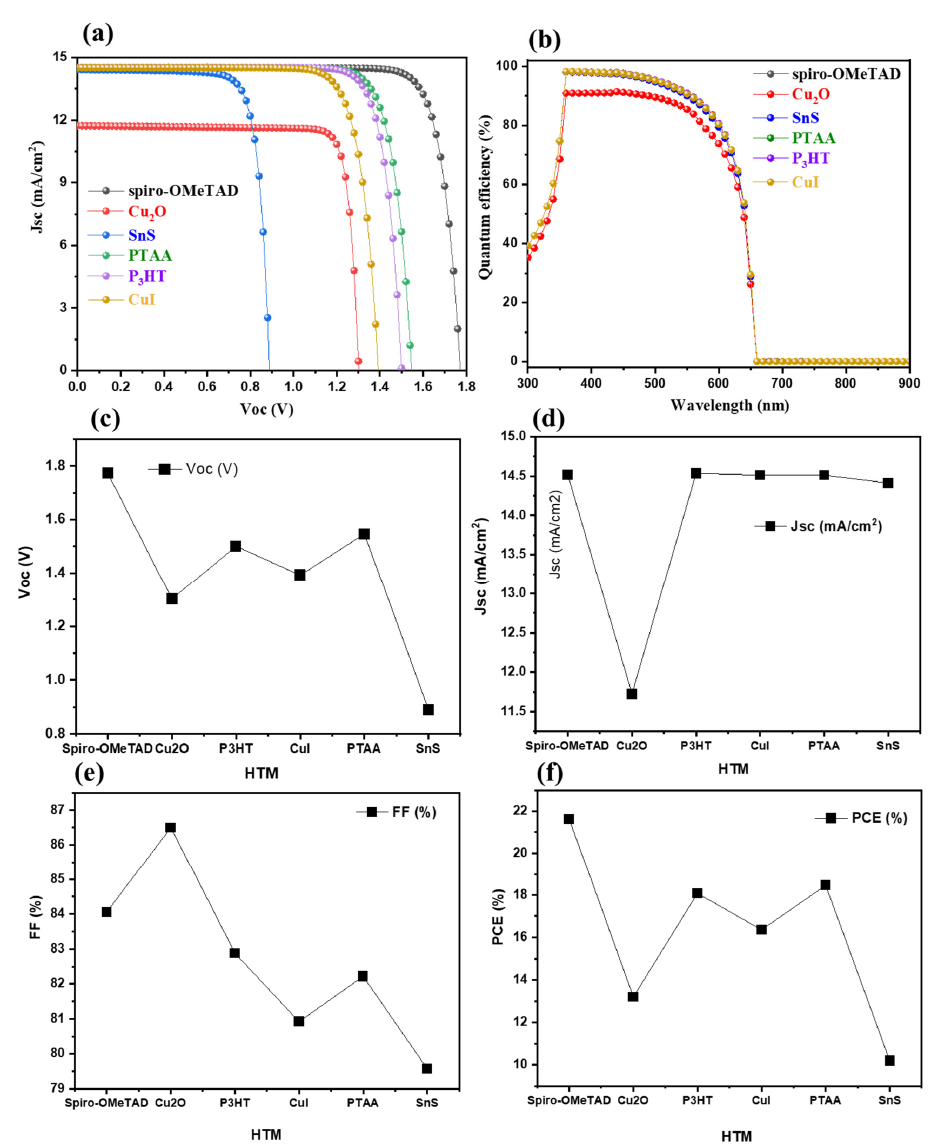
Figure 5. J-V curves ( a ) and EQE curves ( b ) of the simulated PSCs (FTO(500 nm)/ZnOS(100 nm)/MAGeI 3 (550 nm)/different HTL(100 nm)) at 300 K. Extracted Voc( c ), Jsc ( d ), FF ( e ) and PCE ( f ) of the simulated PSCs (FTO(500 nm)/ZnOS(100 nm)/MAGeI 3 (550 nm)/different HTL(100 nm)) at 300